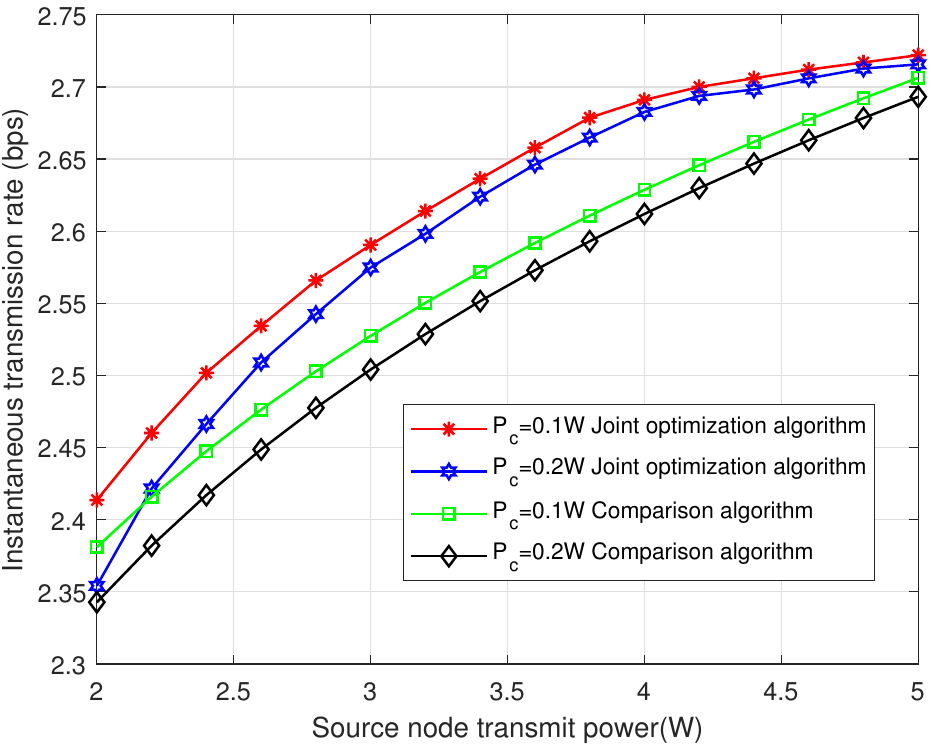
Figure 8. Instantaneous transmission rate versus source node transmit power for the joint optimiza- tion algorithm and the comparison algorithm.